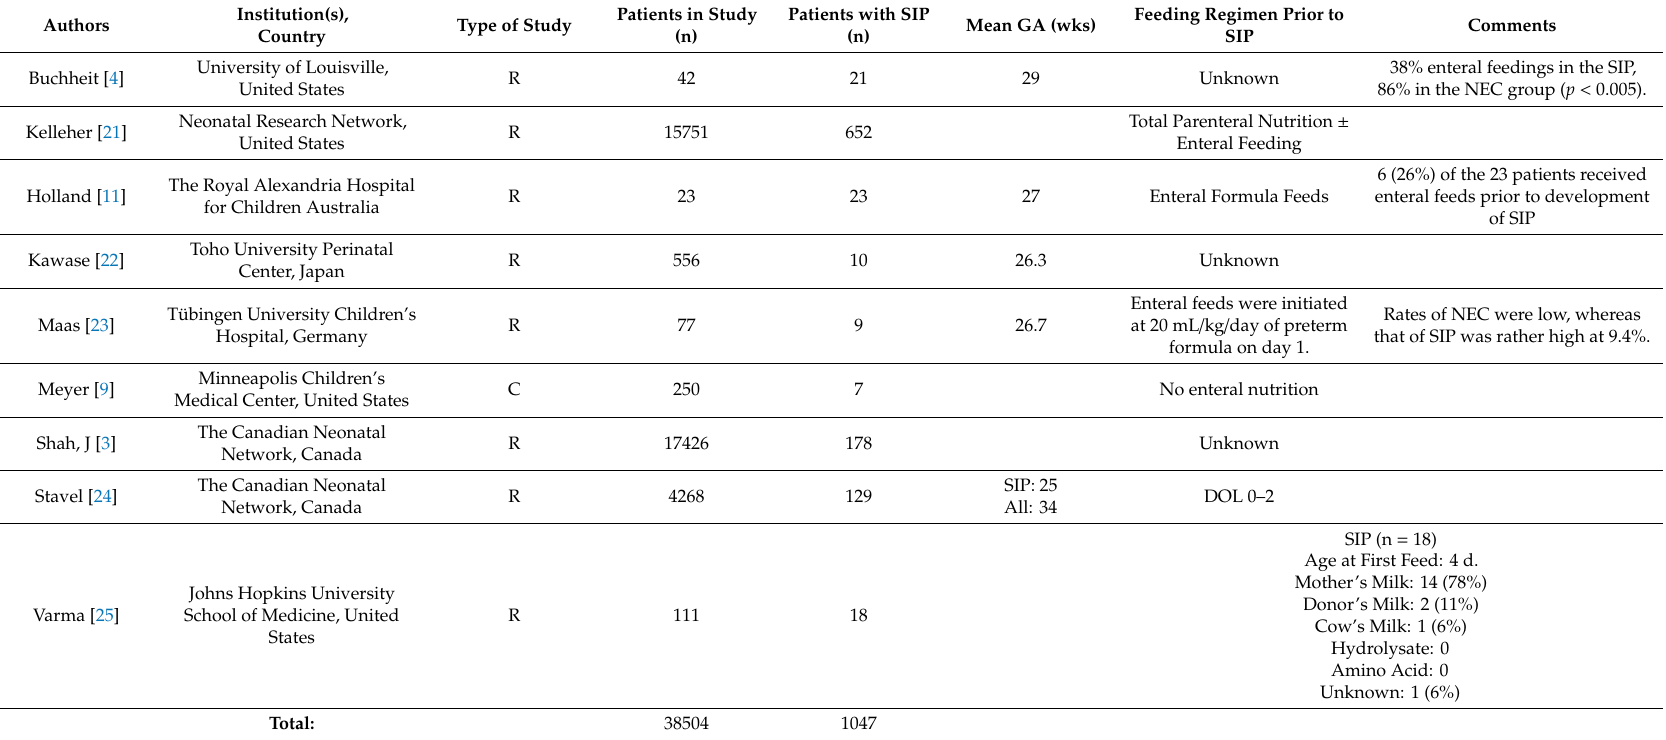
Table 2. Studies with documentation on feeding regimen prior to spontaneous intestinal perforation (SIP) diagnosis.